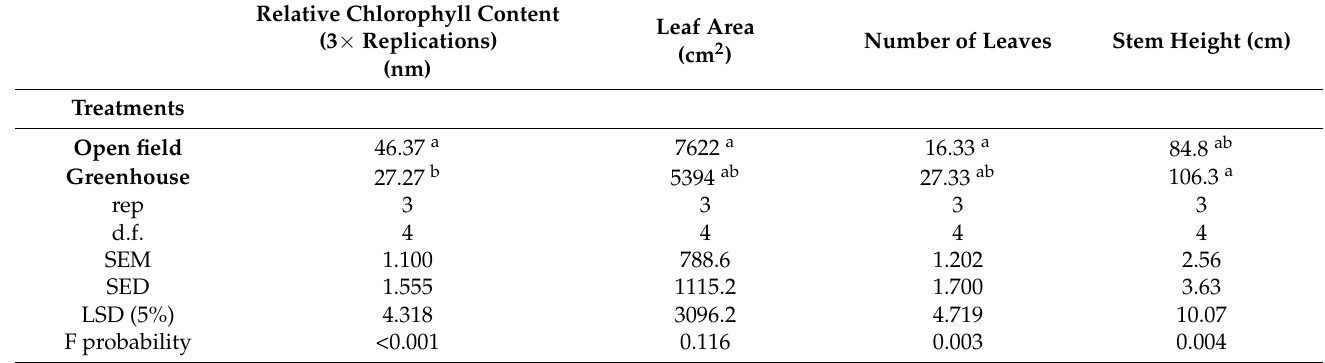
Table 2. Comparison of agronomic parameters A. Cruentus L. in the open field vs. greenhouse.